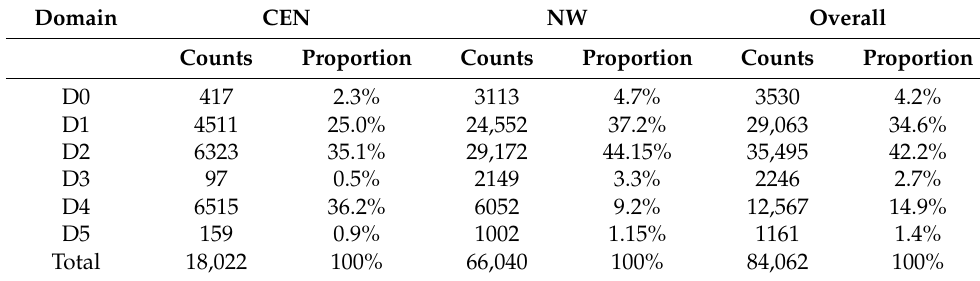
Table 2. Rock domain distribution in the two